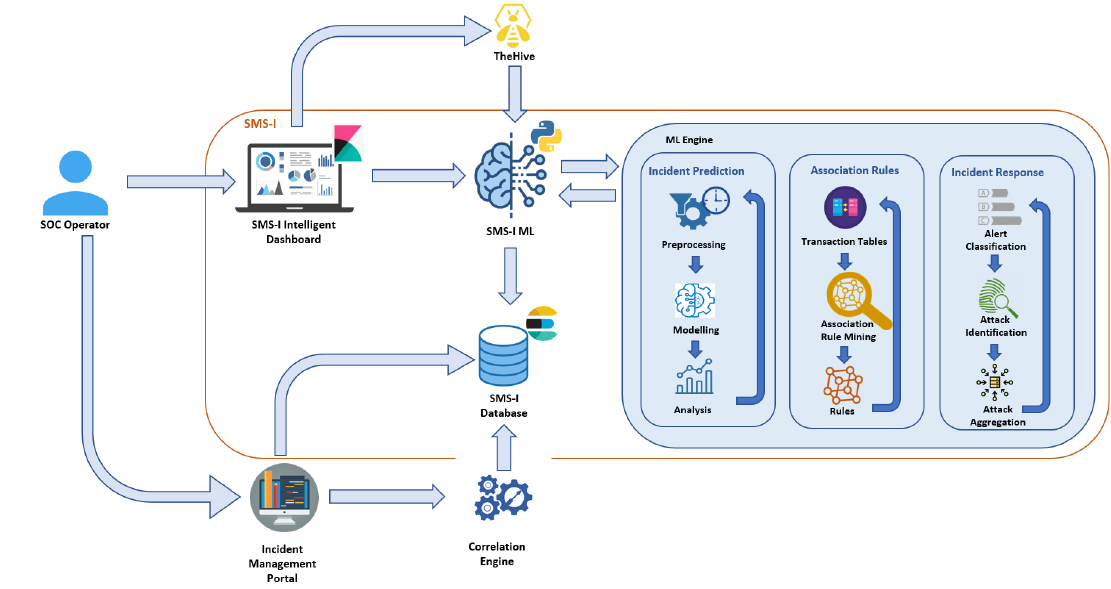
Figure 1. SMS-I architecture